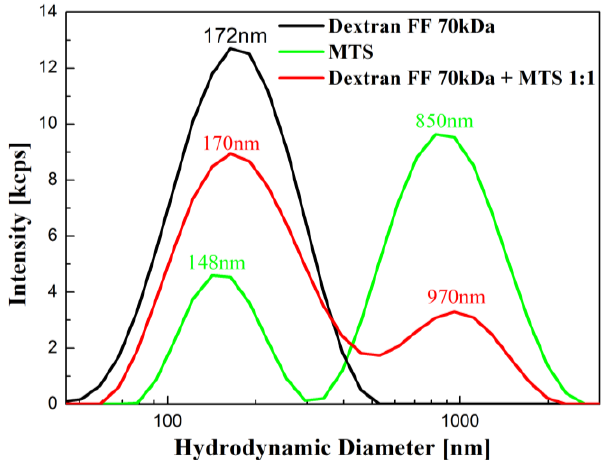
Figure 3. Hydrodynamic diameter distribution of magnetic fluid (dextran-coated Fe 3 O 4 nanoparti- cles), magnetosome chains, and the mixture of magnetic fluid and magnetosomes (ratio 1:1) .